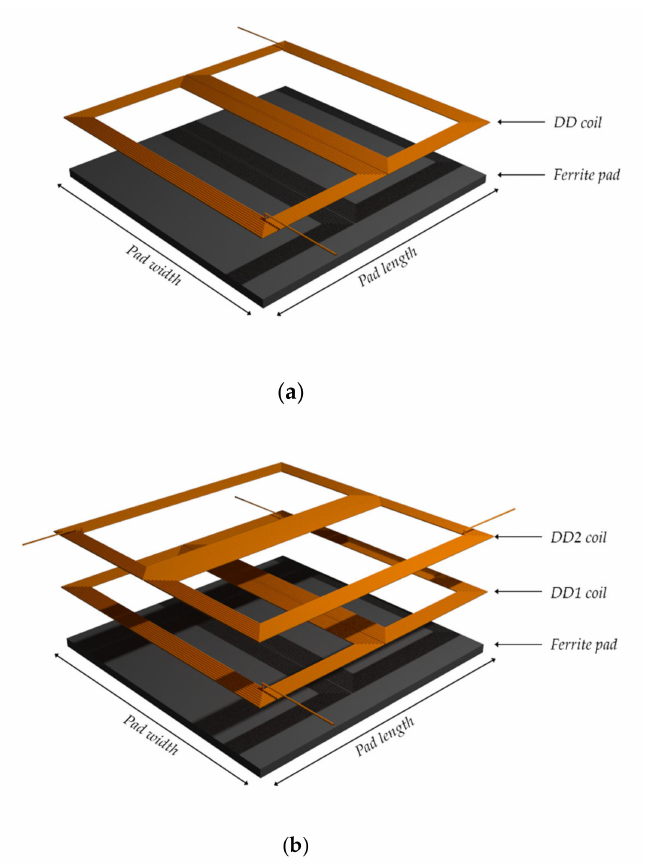
Figure 1. Exploded transmission pad: ( a ) With single DD coil; ( b ) with double DD